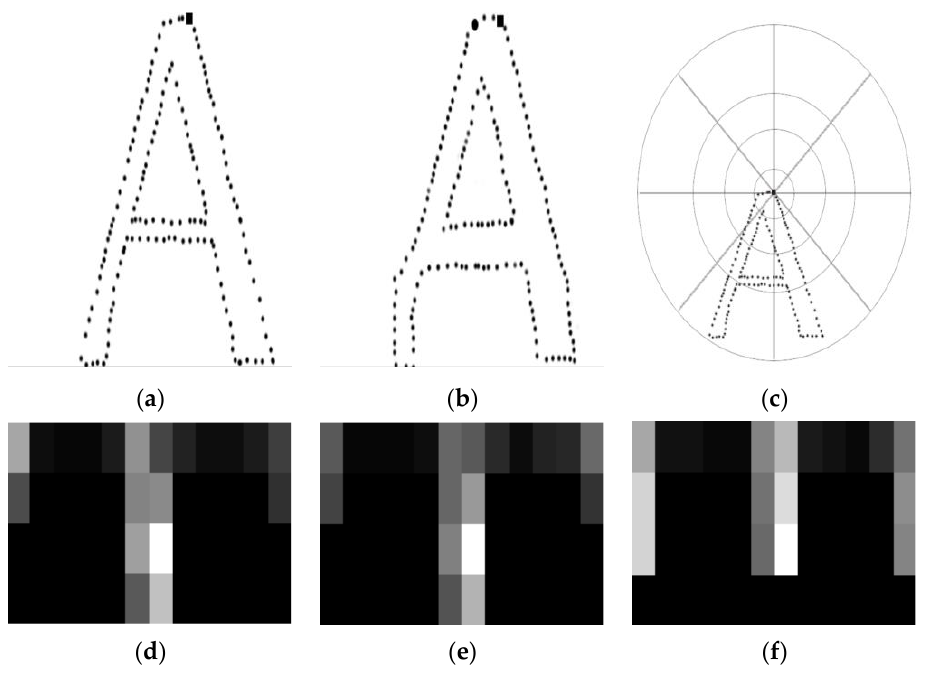
Figure 3. Shape context calculation and similarity. ( a , b ) are the letter “A” by handwritten. ( c ) denotes the log polar coordinate system. ( d , e ) are histograms of the point marked with black square in ( a , b ), respectively. ( f ) is the histogram of the point marked with black circle in ( b ).